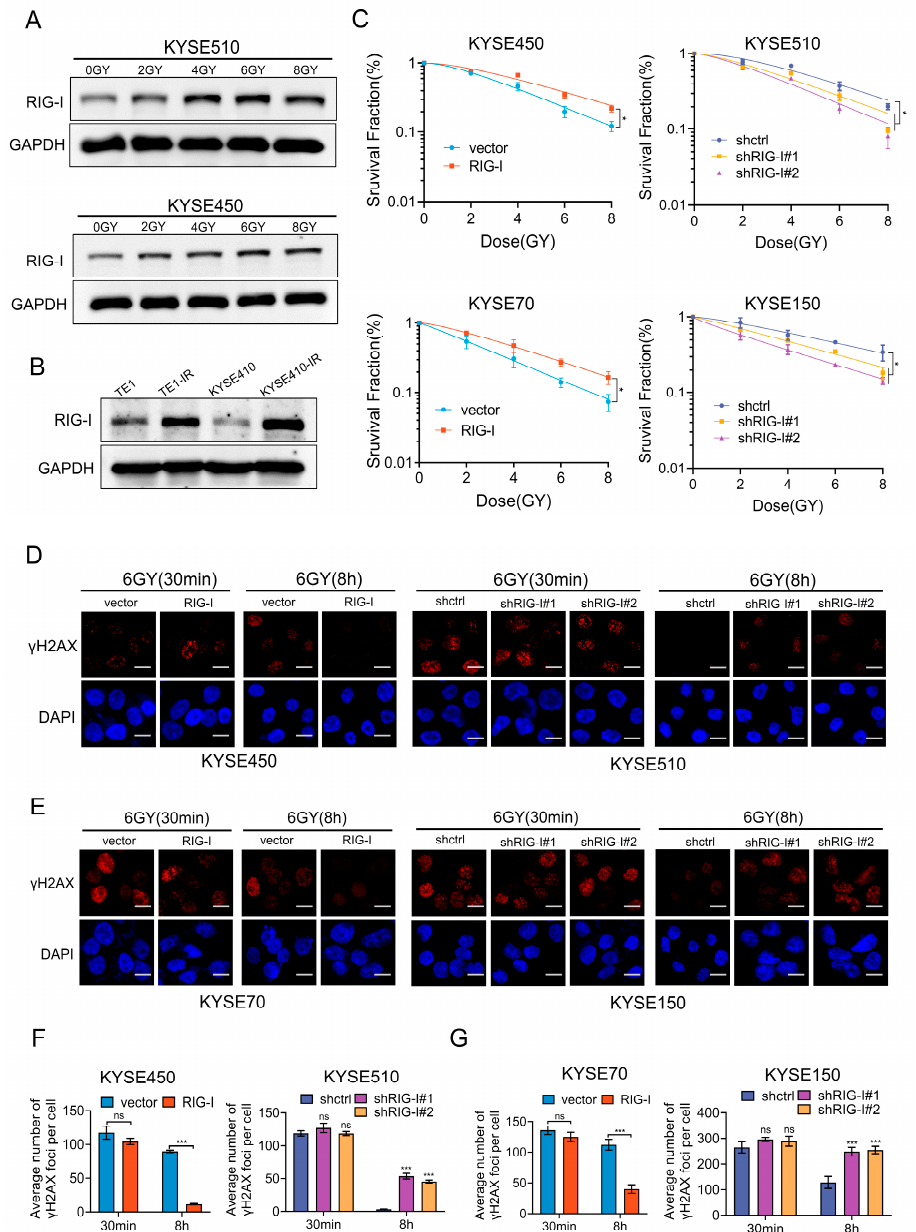
Figure 3. Effect of RIG-I overexpression and silencing on radioresistance of ESCC cells. ( A ) KYSE450 and KYSE510 were exposed to different doses of ionizing radiations (0, 2, 4, 6, and 8 Gy, 2 Gy/min), and RIG-I protein expression levels were detected using Western blotting. GAPDH was used as an internal control. ( B ) Protein levels of RIG-I in radiation-resistant TE-1 and KYSE410 cells and the corresponding naked cells (determined using Western blotting). GAPDH was used as an internal control. After stable RIG-I overexpression or depletion, ( C ) KYSE70, KYSE450, KYSE150, and KYSE510 cells were exposed to different doses (0, 2, 4, 6, and 8 Gy, 2 Gy/min) and cultured for 14 days to detect radiosensitivity using colony formation assay; cell survival curve was fitted by the single-hit multi-target model. ( D , E ) γ -H2AX foci levels in KYSE70, KYSE450, KYSE150, and KYSE510 cells were detected using immunofluorescence after 30 min and 8 h of 6Gy irradiation (40 × magnification). Scale bar = 30 µ m. Empty vector and shRNA-control as controls. ( F , G ) Bar graph represents the average number of γ -H2AX foci per cell in KYSE450, KYSE510, KYSE70, and KYSE150 cells. Empty vector and shRNA-control were used as controls. Data are shown as mean ± SD from three independent experiments, ns: not significant, * p < 0.05 and *** p <